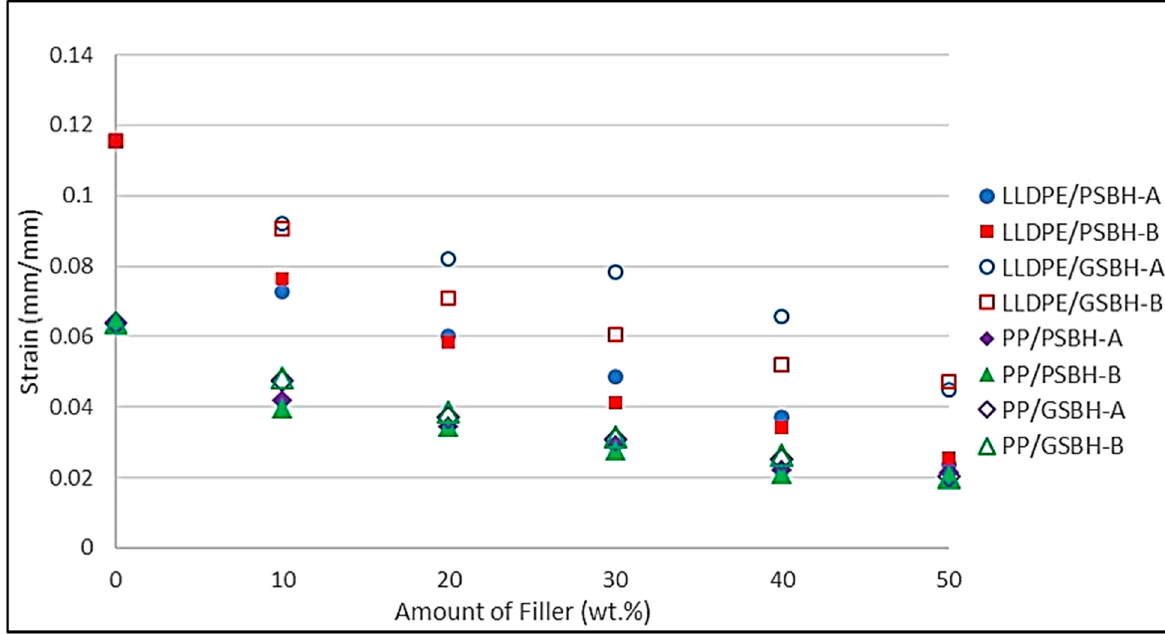
Figure 7. Strain at maximum stress of all composites at all weight percentages. The average strain at maximum stress value of neat LLDPE was found to be 0.116 mm/mm. The values for the different conditions at 50% filler amount were: LLDPE/PSBH- A, 0.024 mm/mm (79.4% decrease); LLDPE/PSBH-B, 0.026 mm/mm (78.0% decrease); LLDPE/GSBH-A, 0.045 mm/mm (61.4% decrease); and LLDPE/GSBH-B, 0.047 mm/mm (59.4% decrease). The standard deviation values varied between 0.001 and 0.012 mm/mm.